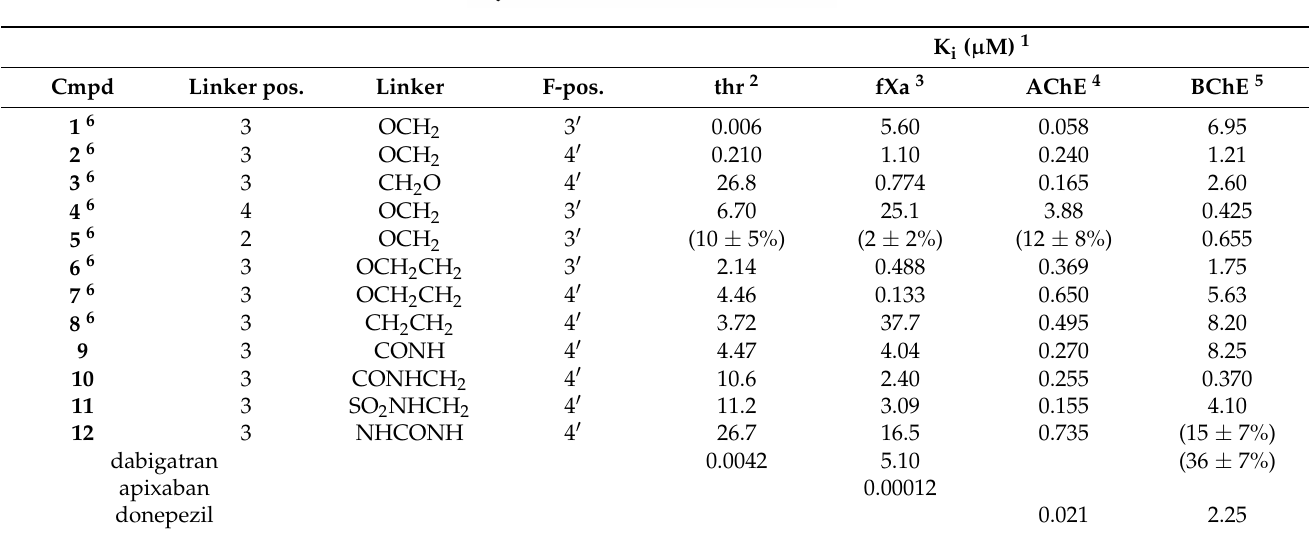
Table 1. Inhibitory activity of analogs of the isonipecotanilide 1 on blood coagulation factors (bovine thr, human recombinant fXa) and cholinesterases ( ee AChE, eq BChE).